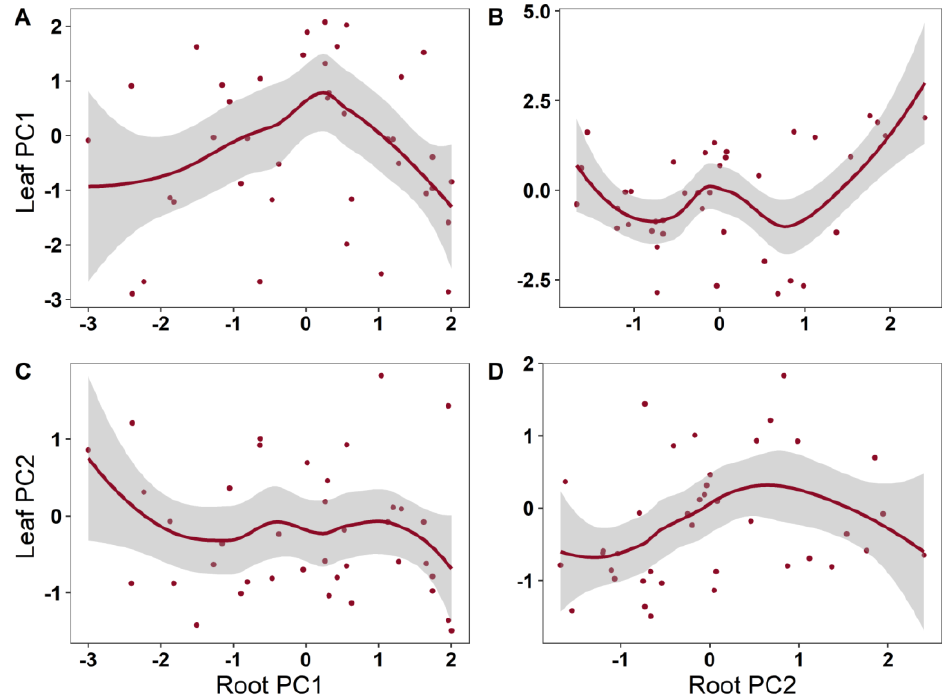
Figure 3. The plots of the GAMs smooth function indicating the effects of root nutrient traits on leaf nutrient traits. ( A ): root PC1 vs. leaf PC1; ( B ): root PC2 vs. leaf PC1; ( C ): root PC1 vs. leaf PC2; ( D ): root PC2 vs. leaf PC2. Table 2. Results of the generalized additive models (GAMs) explaining the influence of soil nutrient and root nutrient traits on leaf and root nutrient traits. * p < 0.05.